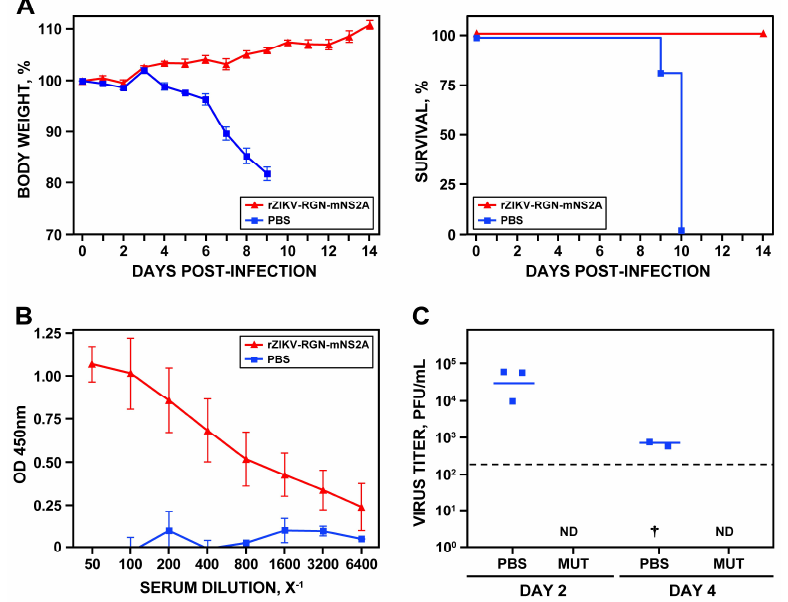
Figure 7. Protection efficacy of rZIKV-RGN-mNS2A. ( A ) Weight loss and mortality. Female 4-to-6- week-old A129 mice (five mice per group) were mock-vaccinated (PBS) or vaccinated s.c. in the footpad with 10 5 PFU of rZIKV-RGN-mNS2A. At 21 days after vaccination, mice were challenged with 10 5 PFU of rZIKV-RGN and the body weight loss (expressed as the percentage of starting weight, left panel) and survival (right panel) were monitored daily during 14 days. Mice that lost more than 20% of their initial body weight or presented hind limb paralysis were humanely euthanized. Error bars represent standard deviations of the mean for each group of mice. ( B ) Induction of humoral response. One day before challenge with rZIKV-RGN, sera samples were collected from mock-vaccinated (PBS) and rZIKV-RGN-mNS2A vaccinated mice, and total IgG antibodies against ZIKV-RGN were evaluated by ELISA. OD, optical density. Error bars represent standard deviations of the mean for each group of mice. ( C ) Viral titers in mice sera. Female 4-to-6-week-old A129 mice (six mice per group) mock-vaccinated (PBS) or vaccinated with 10 5 PFU of rZIKV-RGN-mNS2A (MUT) were challenged with 10 5 PFU of rZIKV-RGN as described above, and viral titers in sera were determined at days two and four after challenge (three animals per time point) by plaque assay and immunostaining using the pan-flavivirus E protein mAb 4G2. Symbols represent data from individual mice and bars the geometric means of viral titers. †: virus not detected in one mouse; ND: virus not detected. The limit of detection of the assay (200 PFU/mL) is indicate as a dashed